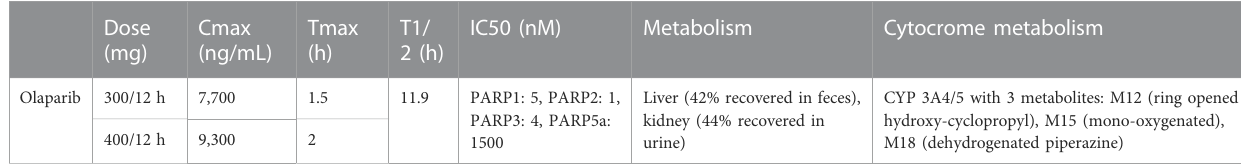
TABLE 1 Pharmacokinetics and pharmacodynamics of olaparib. Dose